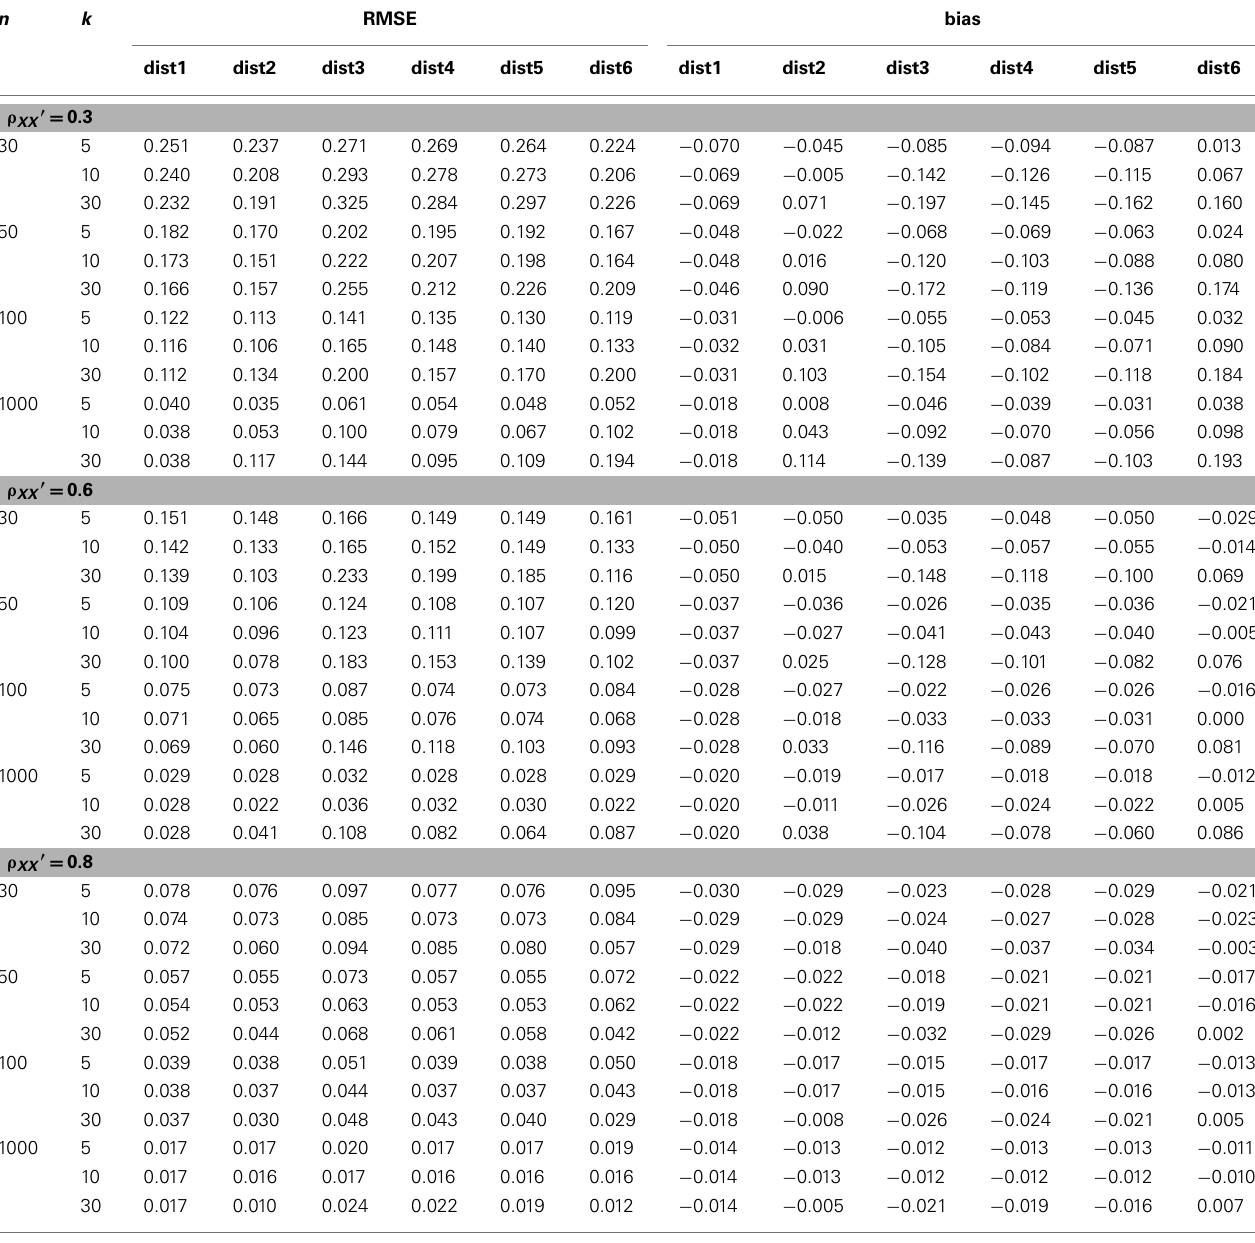
Table 5 | Root mean square error and bias for estimating α for the simulated situations where the error score ( e ij ) distribution is normal or non −